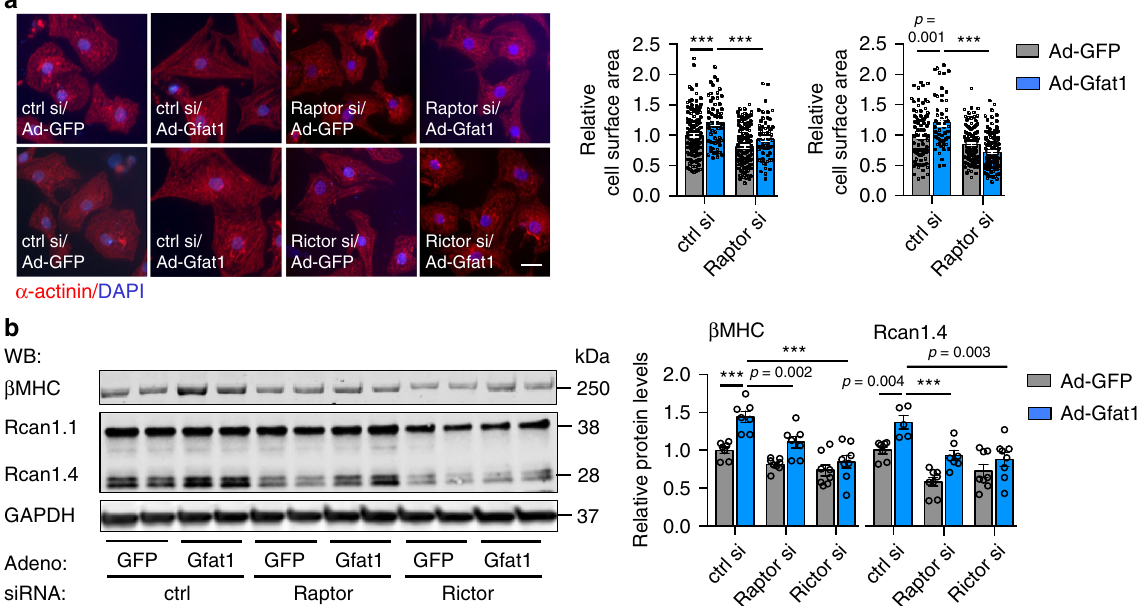
Fig. 8 Both mTORC1 and mTORC2 contribute to Gfat1-mediated cardiomyocyte growth. a Knockdown of either Raptor or Rictor reduced Gfat1-mediated cardiomyocyte growth. NRVMs were transfected by siRNAs against Raptor or Rictor along with controls. Adenovirus expressing GFP or Gfat1 was then used to infect the cells. After immuno fl uorescent staining, cardiomyocyte size was quanti fi ed (right). Scale: 20 μ M. N = 55 – 153/cells for each group. At least three independent experiments were conducted with 2 – 3 samples/group/experiment. b Protein expression of β MHC and Rcan1 was determined by Western blotting. Quanti fi cation at the right showed a signi fi cant decrease in expression by knockdown of either Raptor or Rictor, indicating both mTORC1 and mTORC2 contribute to Gfat1-mediated cardiomyocyte growth. N = 5 – 8. Data are shown as mean ± SEM. Signi fi cance was calculated by